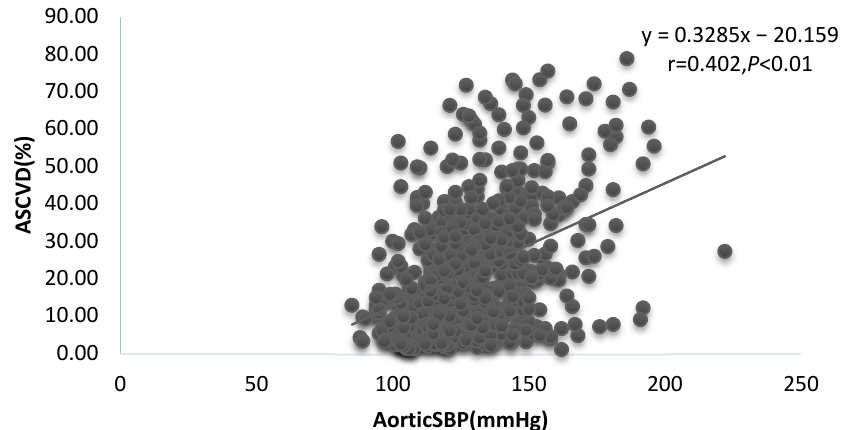
Figure 1. Linear relationship between cfPWV and ASCVD.